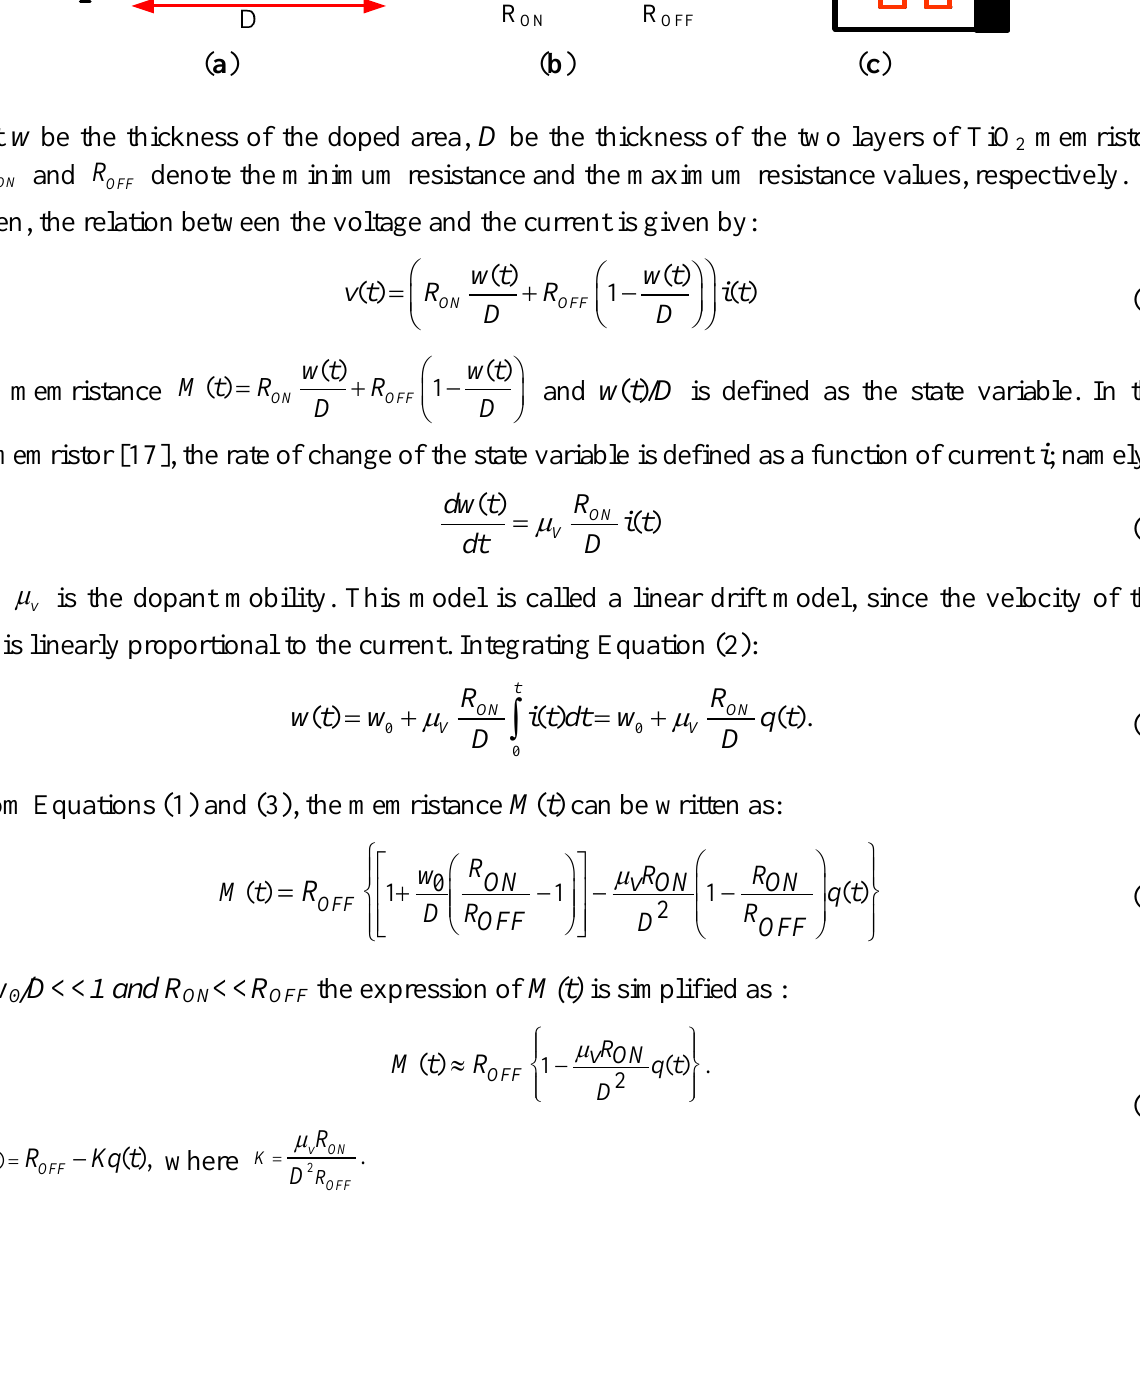
memristor, TiO 2